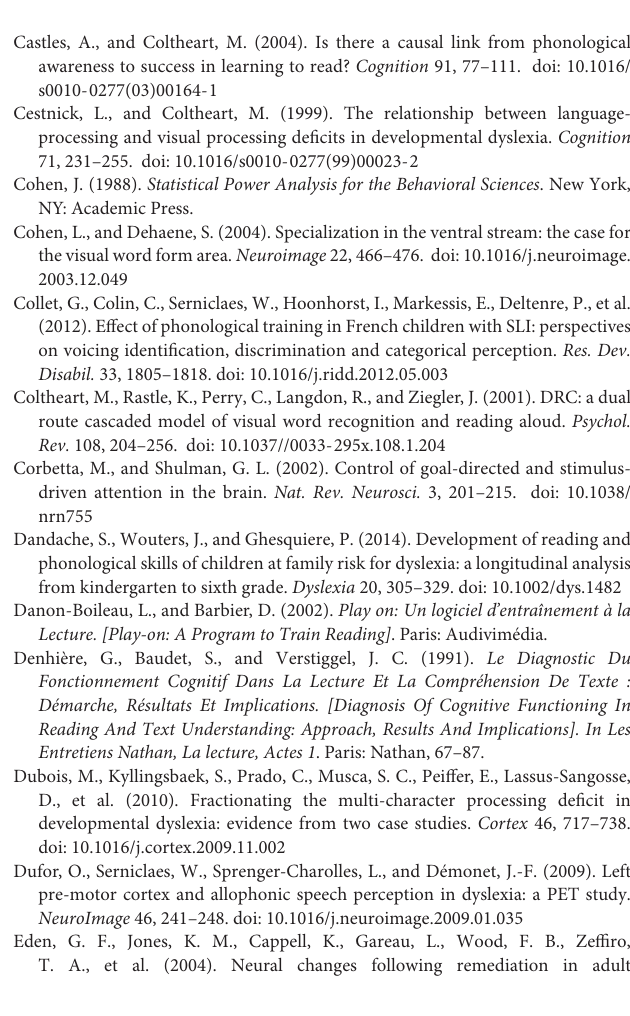
TABLE S1 | Numerical simulations showing that orthogonal contrasts are not